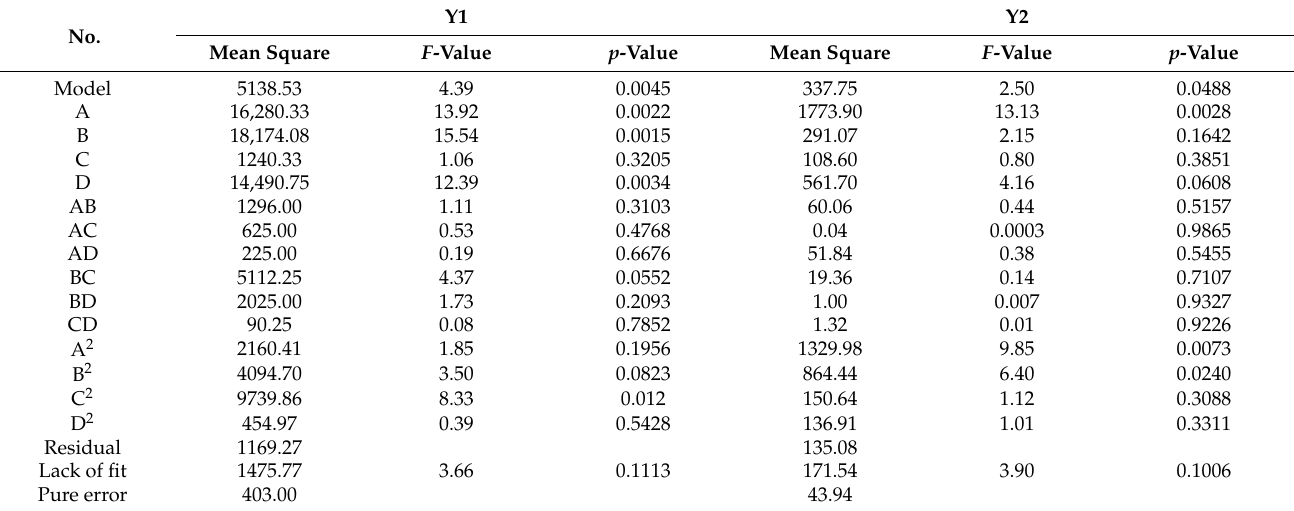
Table 2. Analysis of variance of the quadratic regression equation for particle size (Y1) and encapsu- lation efficiency (Y2) of